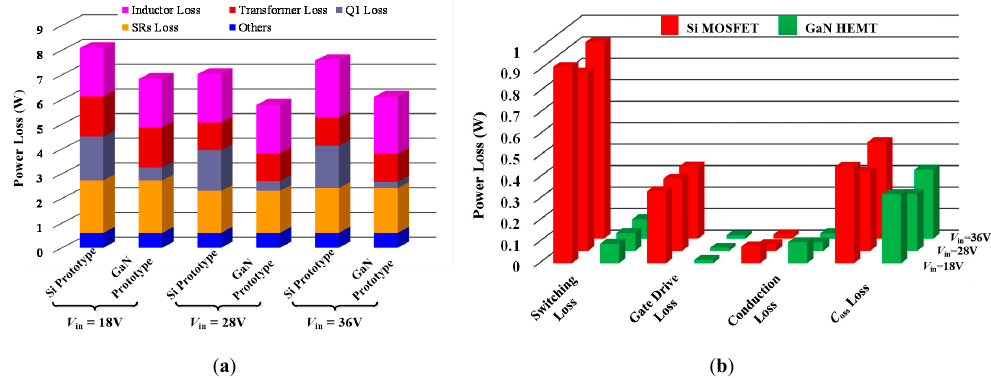
Figure 13. Power loss breakdown and comparison between GaN- and Si-based prototype at full load: